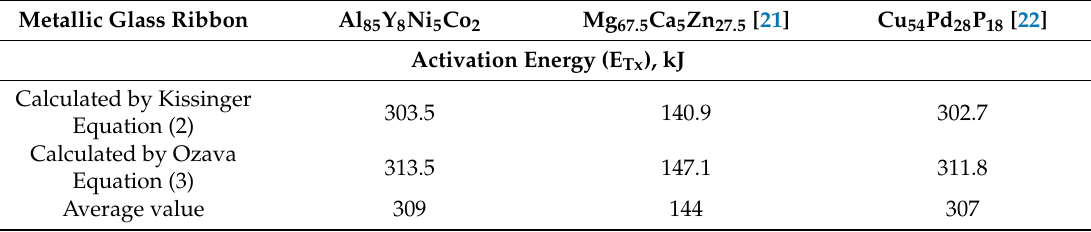
Table 3. The activation energies of the crystallization process in the metallic glasses based on